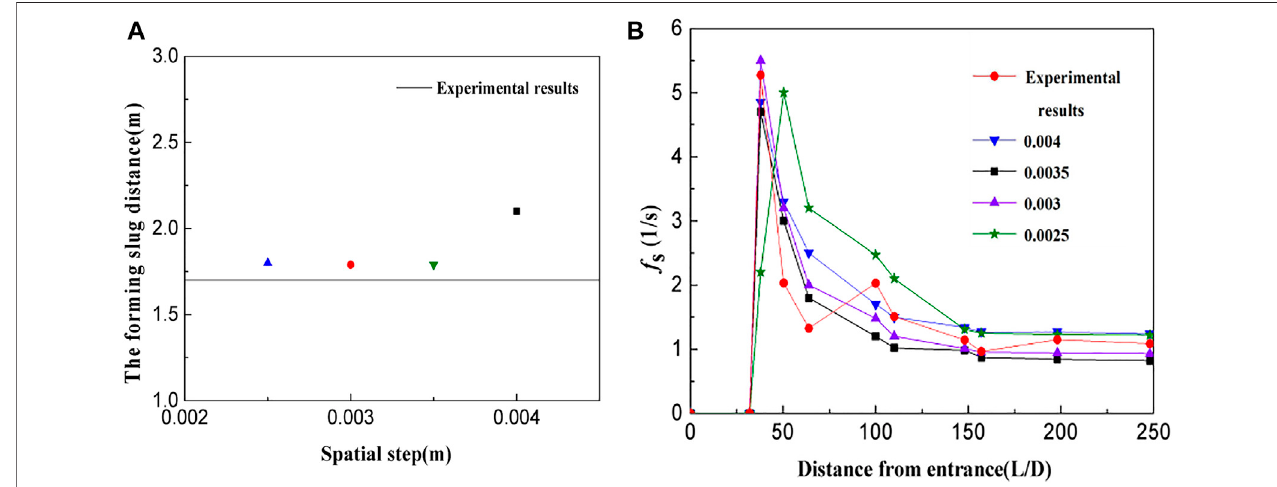
FIGURE 6 | Comparison between simulated and experimental values of (A) slug formation position and (B) slug frequency by different spatial steps.